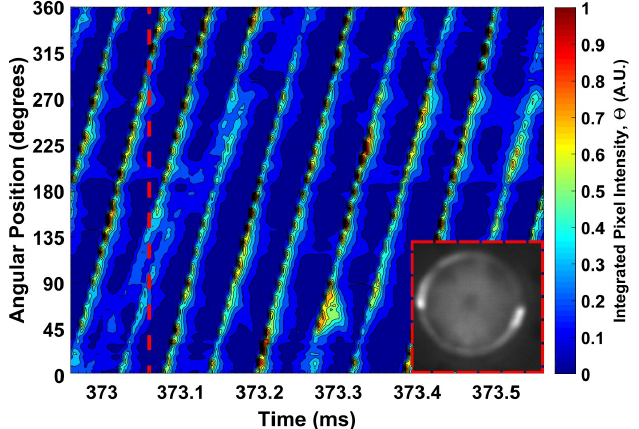
Figure 8. Detonation surface plot showing integrated pixel intensity from experimental data of RDRE during DMT with trailing wave failure [13].